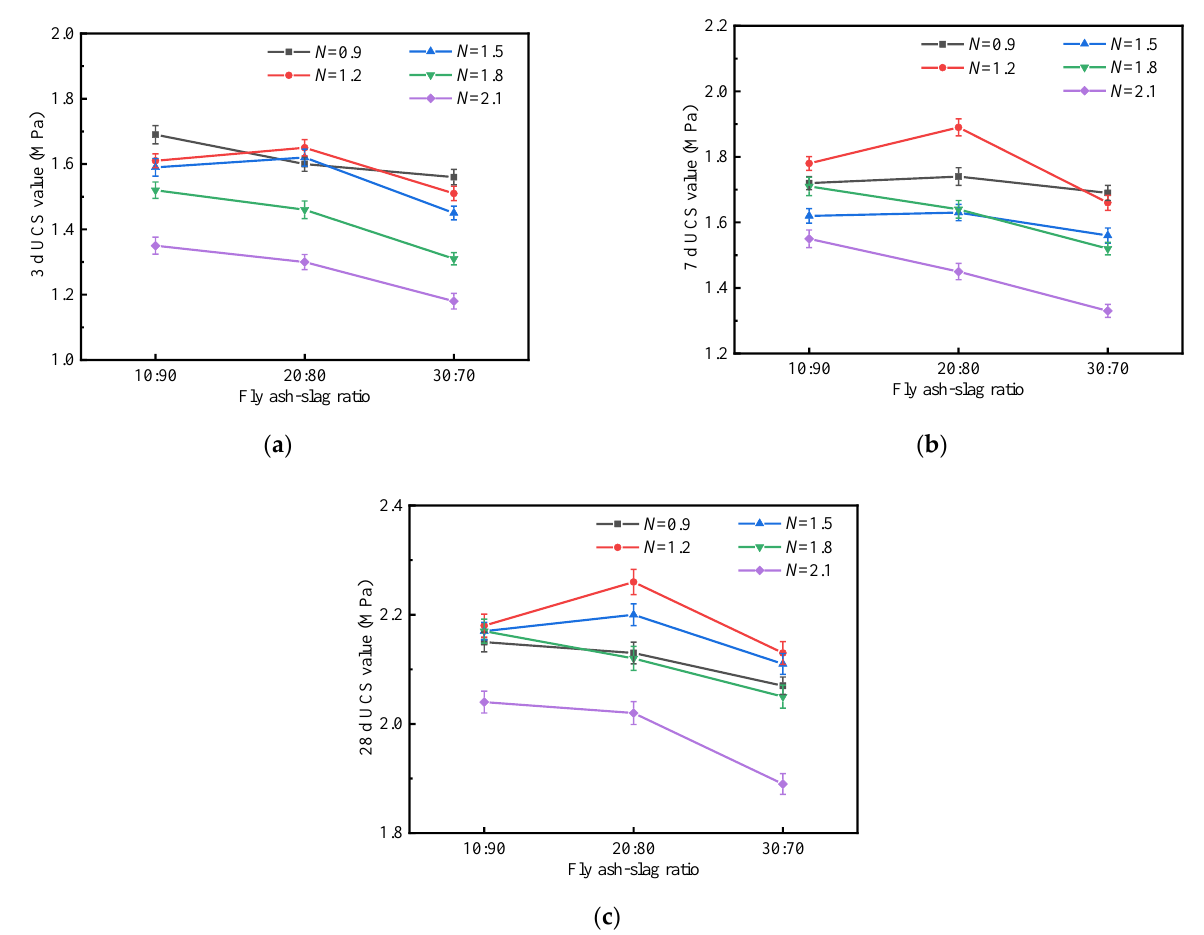
Figure 5. UCS value of stabilized soil with different fly ash/slag ratios: ( a ) 3 d; ( b ) 7 d; ( c ) 28